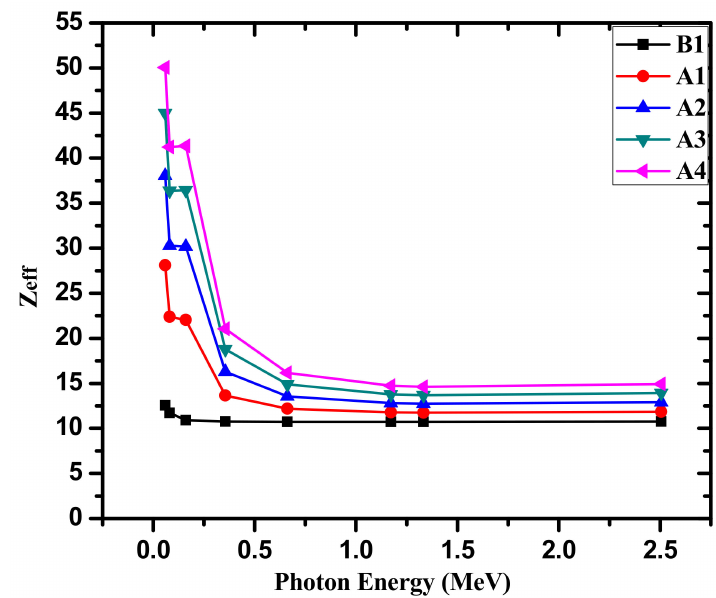
Figure 7. The Z eff for the fabricated glasses.